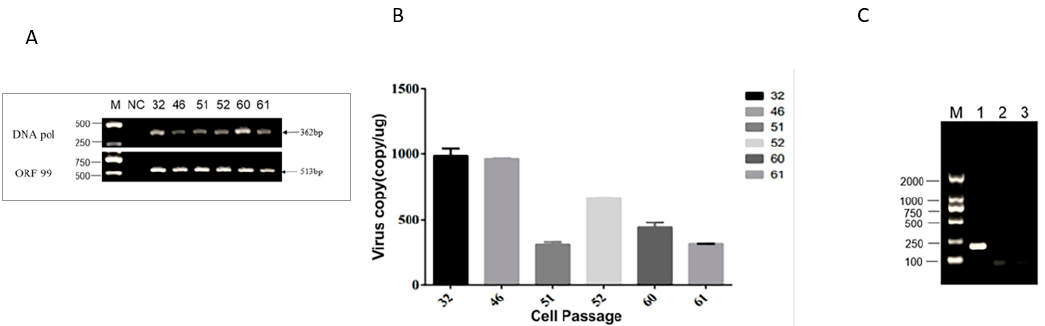
Figure 4. Examination of CyHV-2 DNA and gene transcription in the GCBlat1 cell line: ( A ) PCR analysis of the CyHV-2 DNA from GCBlat1 cells at indicated passages. Amplicons of DNA pol (362 bp) and ORF 99 (513 bp) are indicated. ( B ) qPCR analysis of the CyHV-2 DNA in GCBlat1 cells at indicated passages: CyHV-2 DNA copies were calculated similarly as described above. The data shown are the mean of triplicates ± SD. ( C ) RT-PCR analysis of total RNA harvested from GCBlat1 cells of passage 32: Lane 1, β -actin; lane 2, DNA pol (362 bp); lane 3, ORF99 (513 bp); M, DNA ladder. One representative experiment of three is shown.